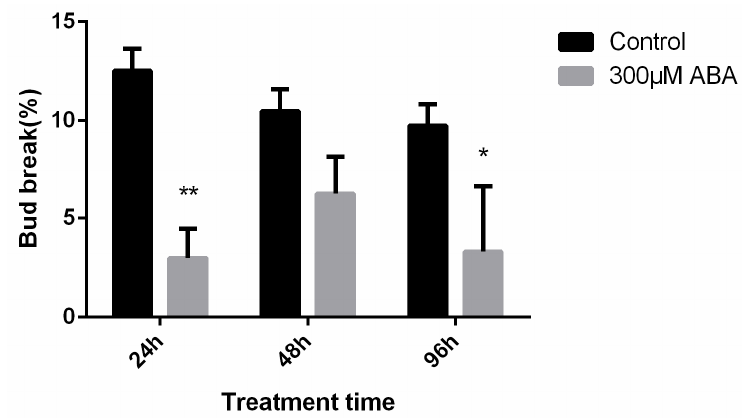
Figure 6. ABA promotes the induction of pear lateral flower bud endodormancy. The pear shoots were collected on 15 October 2016. The shoots were dipped in 300 µM ABA or control (water with 0.02% Triton X-100) for 24, 48, and 96 h. After the ABA treatment, shoots were placed in water for the next 21 days under forcing conditions before measuring the bud-break percentage. The bud-break experiments were performed with three biological replicates and each bar represents the mean ± SEM. Different number of asterisks indicate a significant difference among different treatment time according to Student’s t -test (* p < 0.05, ** p < 0.01).